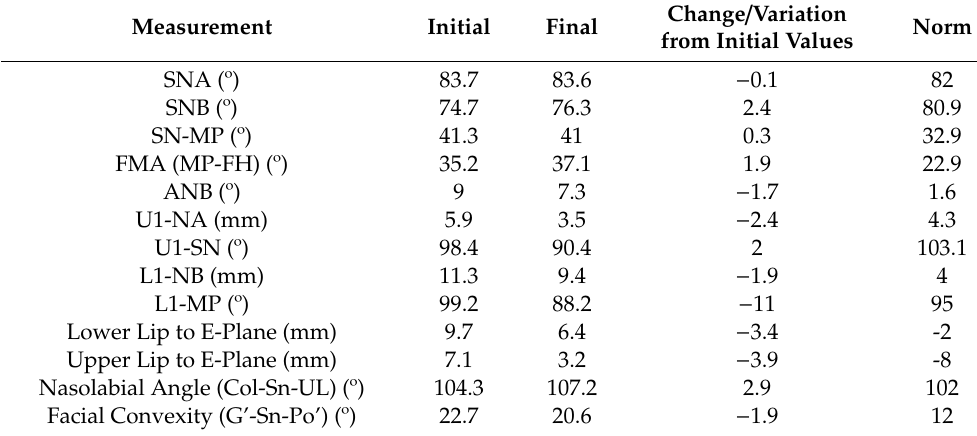
Table 2. Before-and-after treatment cephalometric analyses of Case